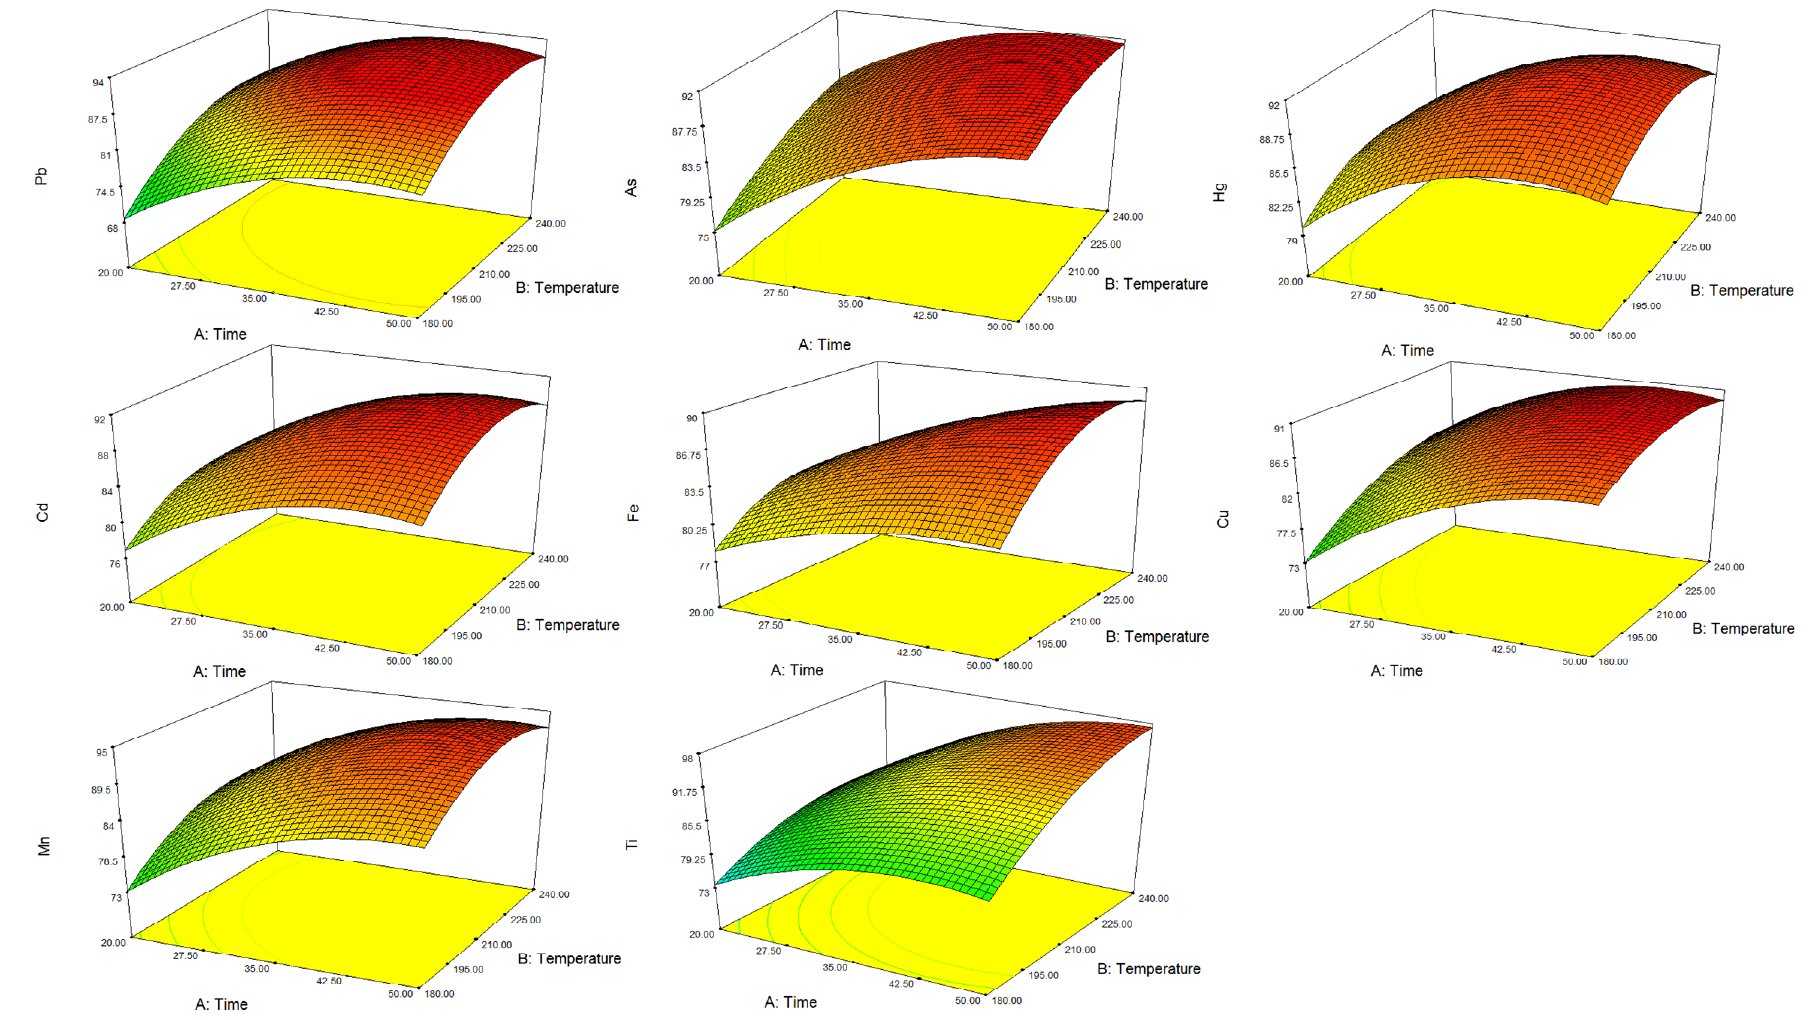
Figure 2. Optimization of ultrawave digestion parameters by BBD. ( A ) Response surface plots (3 D) of Pb, As, Hg, Cd, Fe, Cu, Mn, Ti; ( B ) Response surface plots (3 D) of Ni, V, Cr, Na, K,